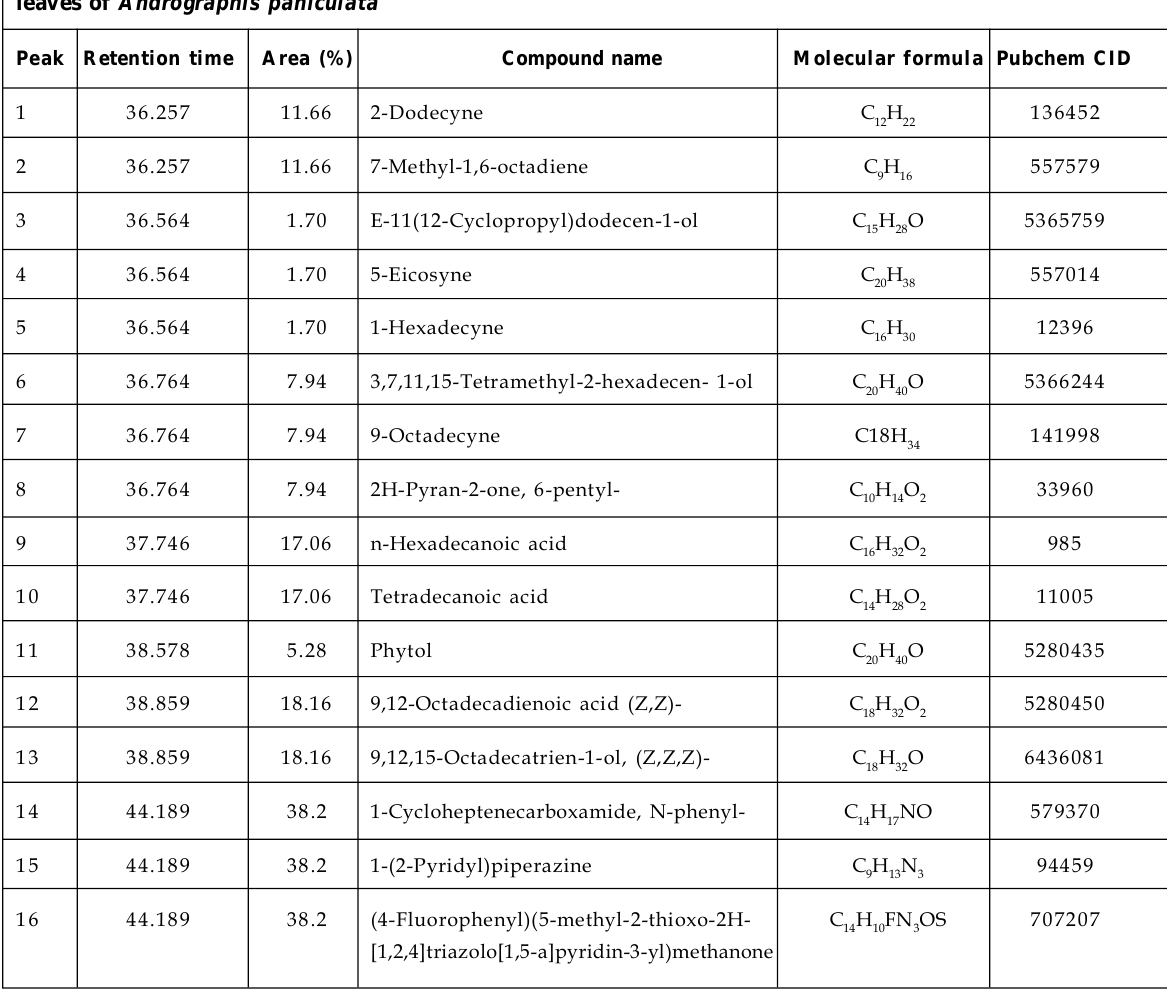
Table 1: List of compounds identified by GC-MS at various retention times from DCM-Methanol extract of leaves of Andrographis paniculata